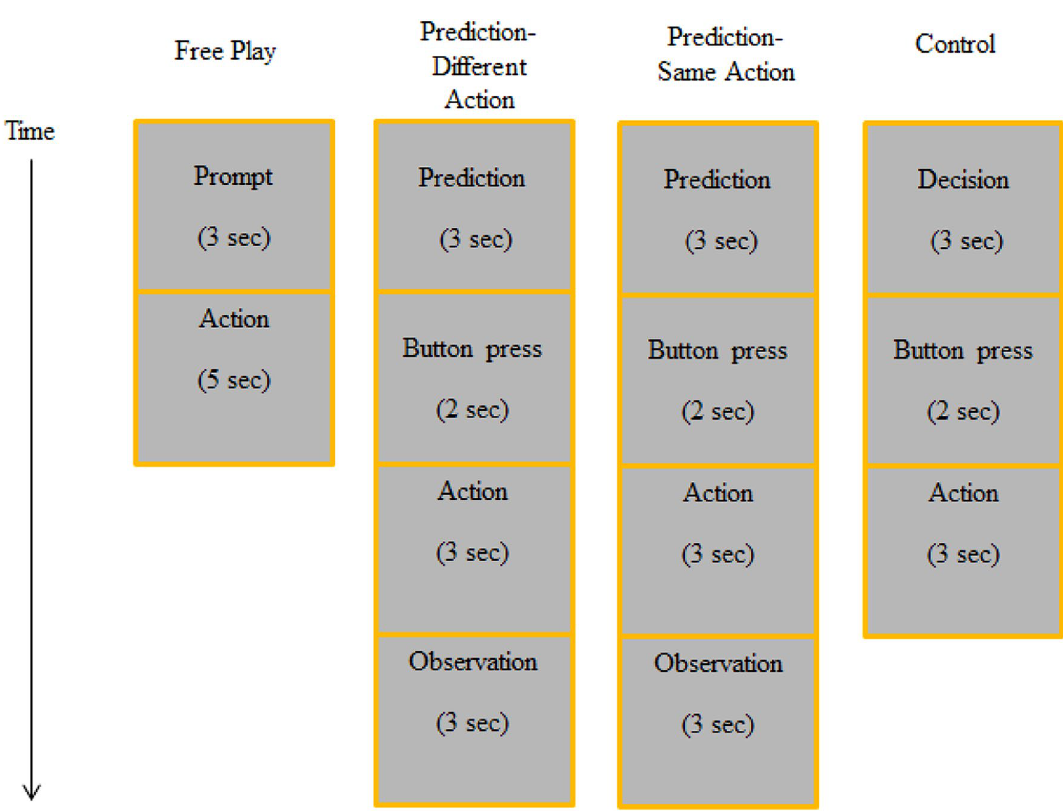
Figure 2. The structure and duration of four experimental conditions in the